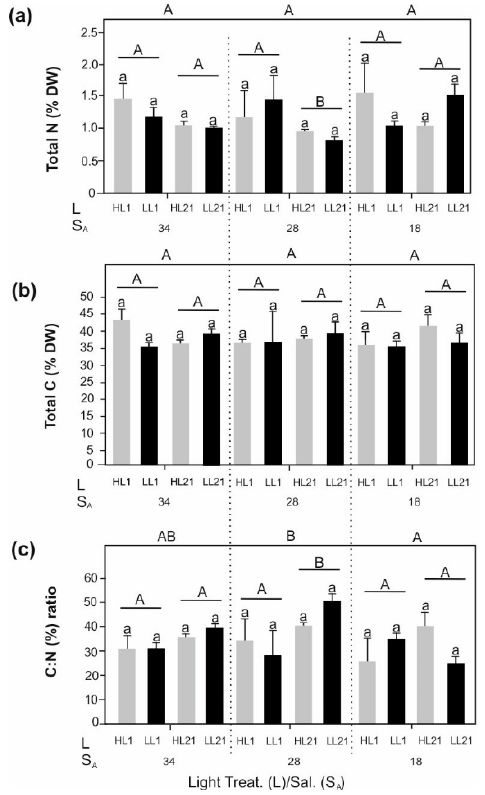
Figure 2. Elemental composition of Desmarestia aculeata at days 1 and 21 of treatment. ( a ) Contents of total N (% DW); ( b ) Contents of total C (% DW); ( c ) C:N ratio. Experimental set–up: salinity (S A )—Light (L) (High Light (HL)–Low Light (LL)) treatments. Values are means ± SD (n = 3). Statistically significant differences between HL and LL per treatments are marked by different lowercase letters. Statistically significant differences between treatment days (1–21) are marked by different uppercase letters and differences between salinities (S A 34, 28, and 18) are marked by different uppercase letters outside the graph. For all the data, three-way ANOVA with post-hoc Tukey’s test was performed ( p < 0.05).